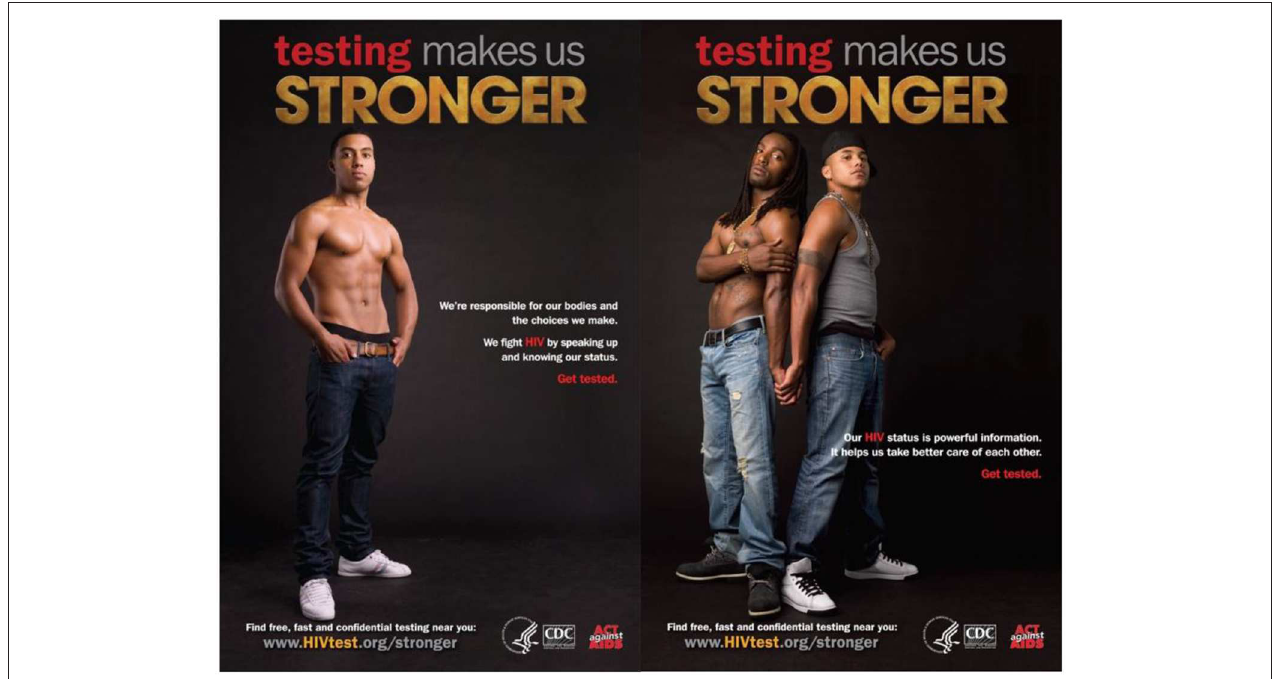
FIGURE 1 | Sample TMUS campaign materials [Testing Makes Us Stronger Poster (Digital image),